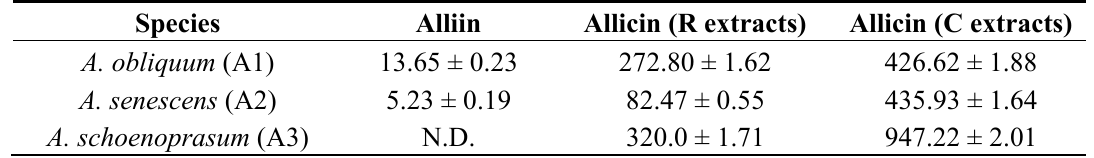
Table 2. The content in alliin (mg/100 g vegetal product) and allicin (mg/100 g vegetal product) of Allium species extracts.